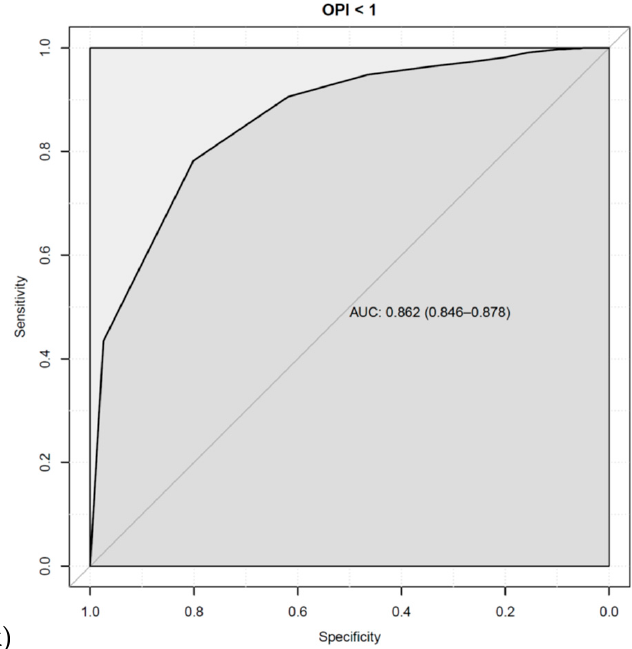
Figure 1. Receiver-operating characteristic curve (ROC) curves (with AUC and associated 95% confidence interval) are displayed to determine the optimum balanced sensitivity and specificity of TFBUT to predict pathological ocular surface disease index (OSDI) >12 (AUC = 0.579, 0.550 – 0.608) in subfigure ( a ); meibomian gland dysfunction (MGD) >0 (AUC = 0.578, 0.523 – 0.634) in subfigure ( b ); osmolarity >308 (AUC = 0.538, 0.508 – 0.568) in subfigure ( c ) and >316 (AUC = 0.558, 0.522 – 0.593) in subfigure ( d ); Schirmer I test (ST) ≤ 5 (AUC = 0.623, 0.592 – 0.654) in subfigure ( e ) and ≤ 10 (AUC = 0.629, 0.605 – 0.654) in subfigure ( f ), ocular surface staining (OSS) >1 (AUC = 0.643, 0.619 – 0.667) in subfigure ( g ) and ≥ 3 (AUC = 0.644, 0.618 – 0.670) in subfigure ( h ), meibum expressibility (ME) ≥ 1 (AUC = 0.626, 0.594 – 0.659) in subfigure ( i ); meibum quality (MQ) >1 (AUC = 0.571, 0.532 – 0.610) in subfigure ( j ); and ocular protection index (OPI) <1 (AUC = 0.862, 0.846 – 0.878) in subfigure ( k ). Table 6. Pearson’s correlation coefficient of determination ( r ) of TFBUT to all other clinical